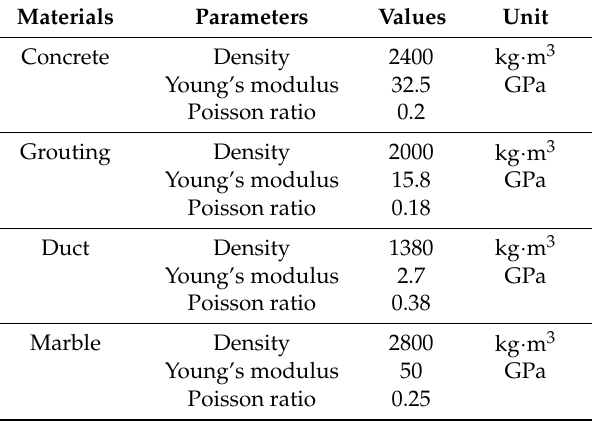
Figure 3. The mesh details of the finite element model. The blue is concrete, the light gray is grouting, the gray is duct, the yellow is PZT and SA, the green is coupling and the skyblue is constraint. Table 1. Material Properties [35,36].